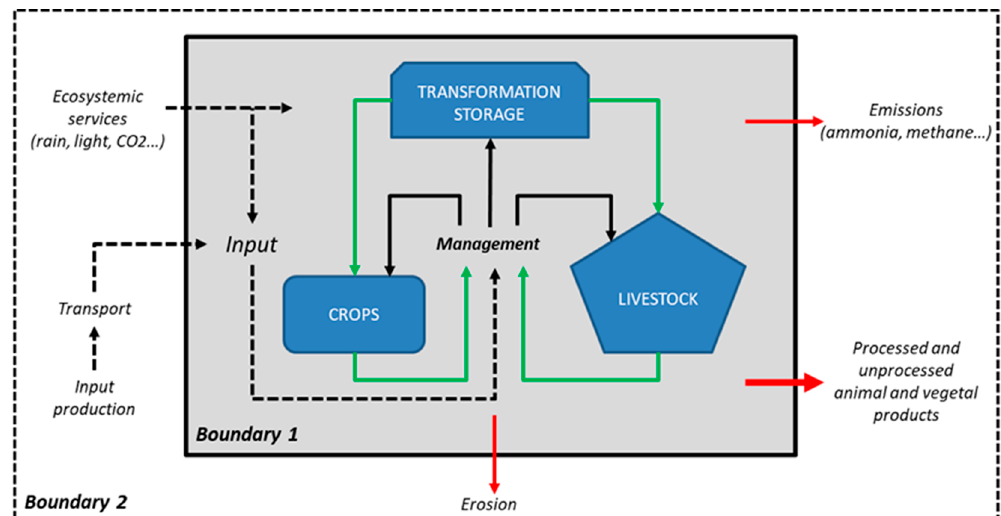
Figure 1. Boundaries of a conceptual farm. The on-farm boundary 1 (solid black line) was used for 16 out of 19 indicators. The off-farm boundary 2 (dotted black line) was used for 3 holistic indicators, i.e., the energy index of renewable flow and the indicators of potential climate impact and GHG emissions. Dotted and solid black arrows refer to flows before and after on-farm management respectively. Green arrows refer to internal flows and red arrows refer to flows leaving the on-farm boundary 1.